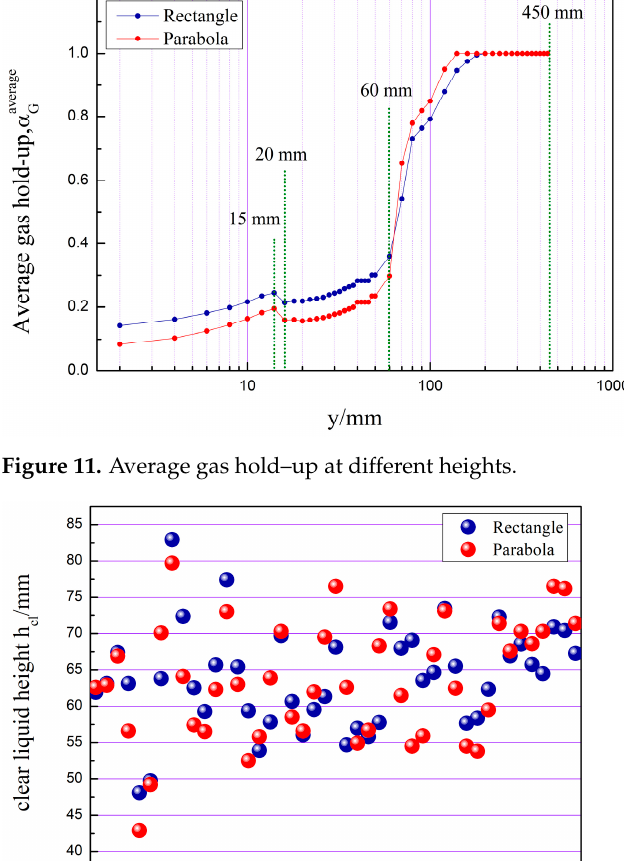
Figure 13. The clear liquid height changes in the z –direction.